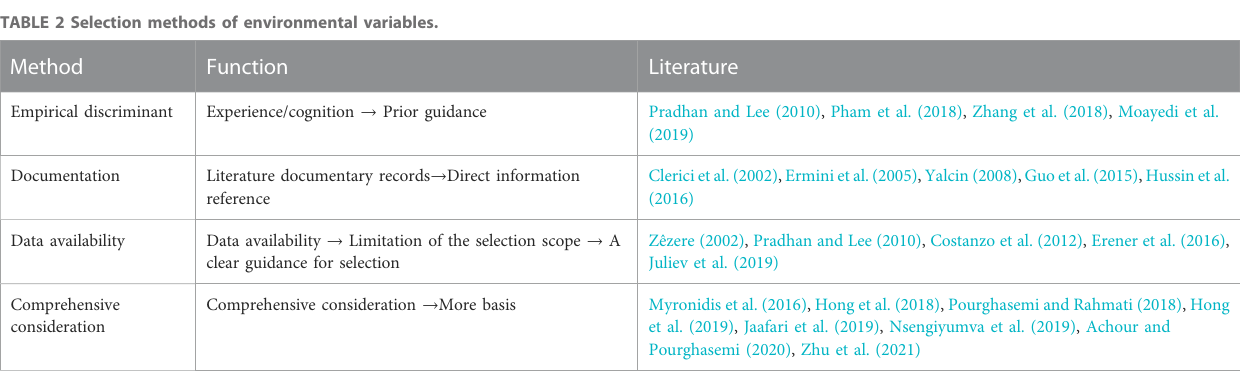
TABLE 2 Selection methods of environmental